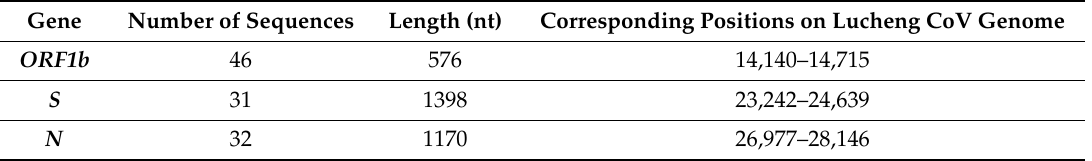
Table 2. List of the different genes used for phylogenetic analyses, number of sequences, sequence length, and corresponding positions on the Lucheng CoV